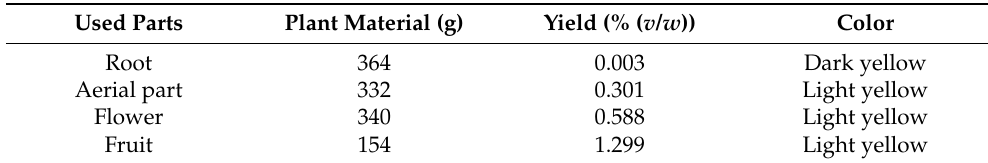
Table 2. The yields of the essential oils and colours of Hypericum scabrum